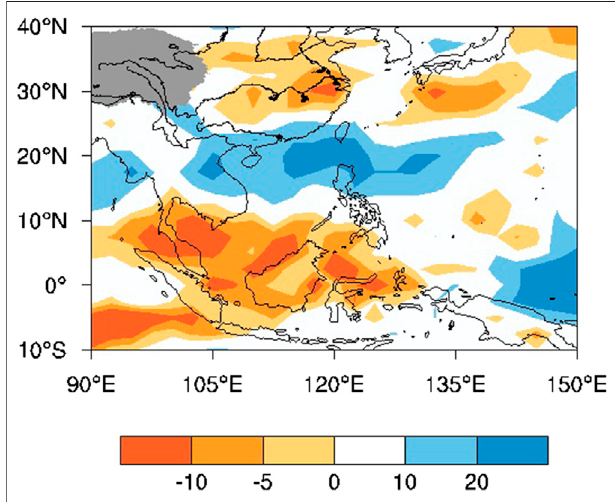
FIGURE 10 | OLR anomaly during July 11 – 19, 2020 (shaded, unit: W m − 2 ). The gray shading denotes Qinghai Tibet Plateau.